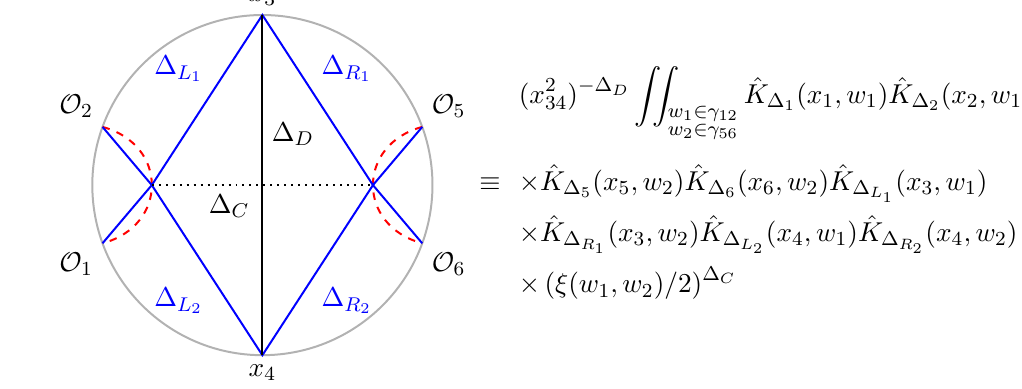
Figure 2 . How to read comb-channel geodesic bulk diagrams. Geodesic bulk diagrams (also referred to as geodesic Witten diagrams) are AdS Feynman diagrams except with all bulk integrations restricted to boundary-anchored geodesics. Throughout this paper, boundary-anchored geodesics over which bulk points are to be integrated will be shown as red-dashed lines. In the diagram above, they represent the geodesics (cid:13) 12 and (cid:13) 56 joining x 1 to x 2 and x 5 to x 6 , respectively. Bulk- to-boundary propagators ^ K (cid:1) ( x; z ) will be shown with solid blue lines, and whenever the conformal dimension (cid:1) associated with it is not clear from the (cid:12)gure, it will be mentioned explicitly. For example, in the six-point geodesic diagram above, the four bulk-to-boundary propagators incident on bulk points to be integrated over boundary anchored geodesics are associated with the conformal dimensions (cid:1) i of the operator insertions O i as marked. The remaining four bulk-to-boundary propagators emanating from the coordinates x 3 and x 4 have conformal dimensions as displayed next to the blue lines. Unless stated otherwise, the operator O i is understood to be located at boundary coordinate x i . Solid black lines will refer to purely boundary contractions; for example in the diagram above the solid black line joining x 3 to x 4 corresponds to a factor of ( x 2 ) (cid:0) (cid:1) D . Finally 34 dotted black lines will stand for factors of chordal distance ( (cid:24) ( w 1 ; w 2 ) = 2) (cid:1) where (cid:24) ( w 1 ; w 2 ) (cid:0) 1 = cosh (cid:27) ( w 1 ; w 2 ) where (cid:27) ( w 1 ; w 2 ) is the geodesic distance between bulk points w 1 and w 2 . We will be using the same propagator normalizations as in ref. [55]; see in particular [55, section 2] for the normalization of the bulk-to-boundary propagator as well as the relation between the bulk-to-bulk propagator and the chordal distance factor